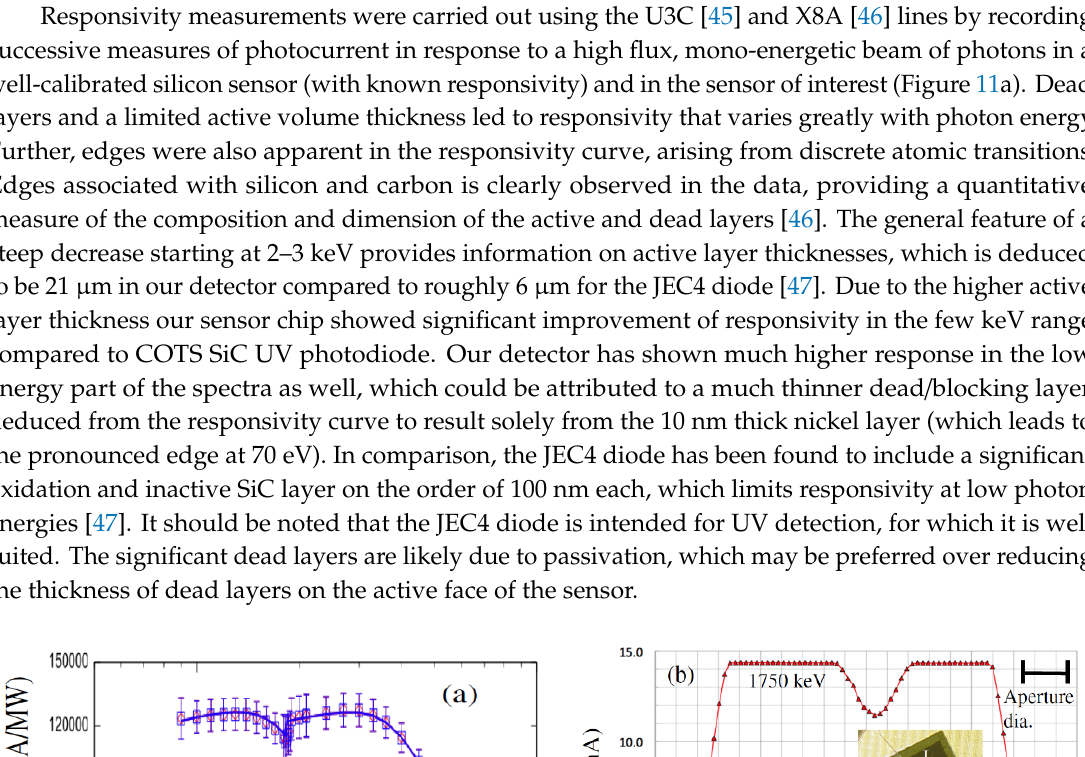
Figure 10. Measured responsivity of a 4H-SiC n-type epitaxial device biased to 250 V and an IFW JEC4 photodiode biased to 120 V.